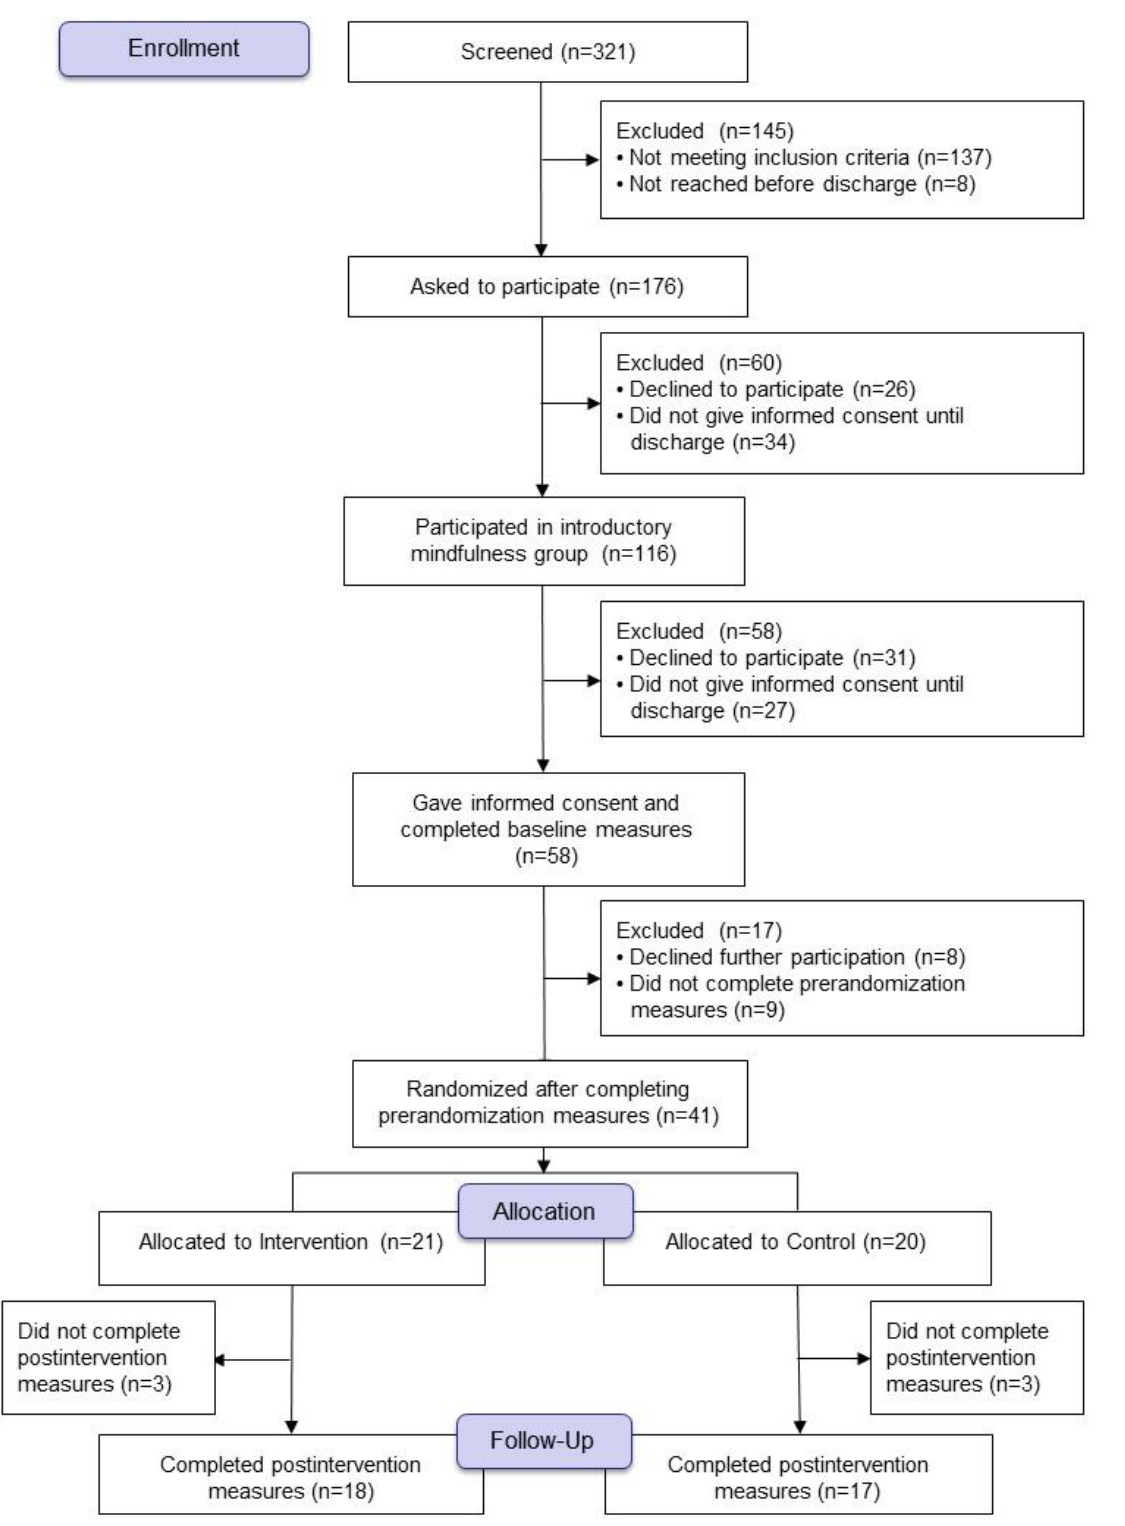
Figure 1. Participant flow through the stages of the